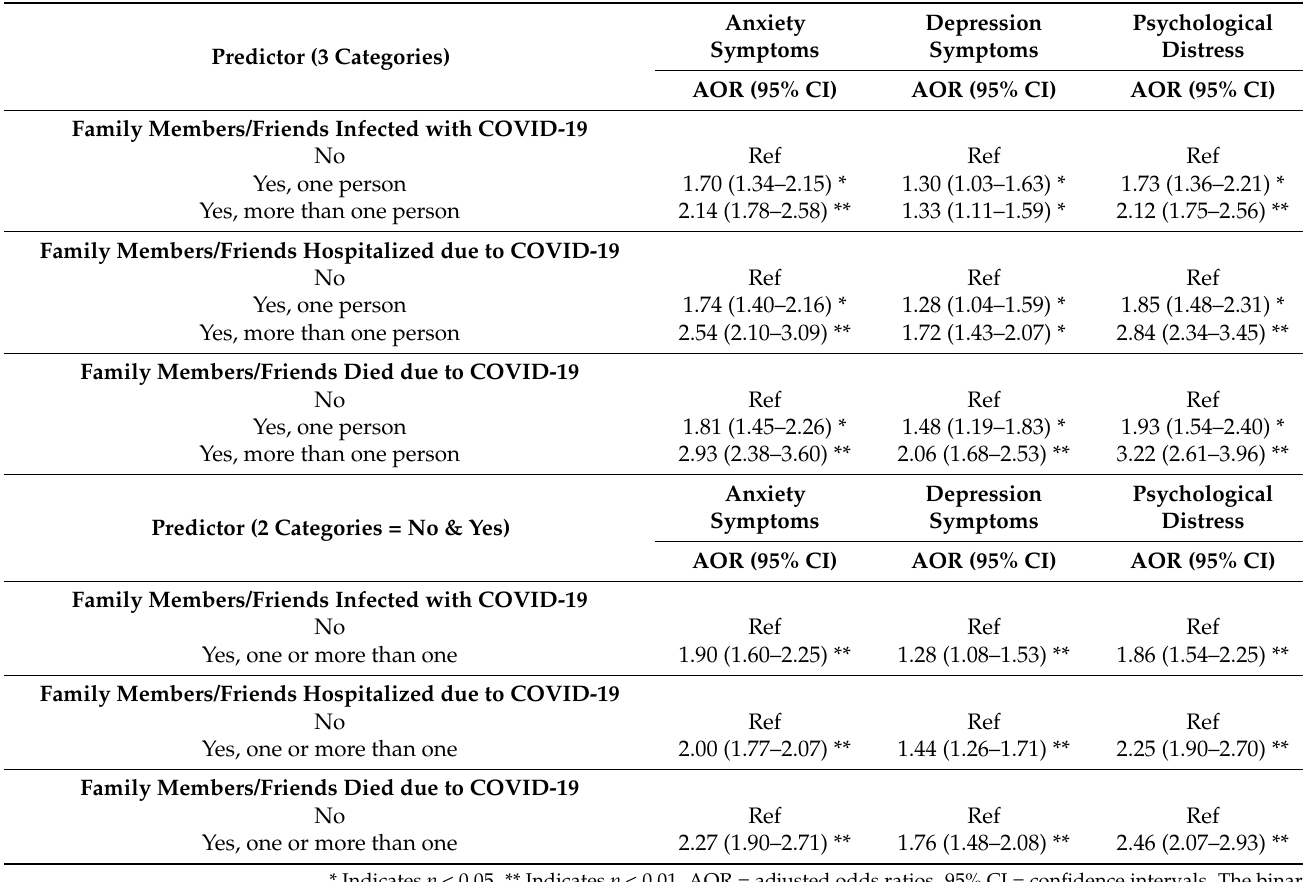
Table 3. Multiple Regression to Predict Depression/Anxiety Symptoms Based on COVID-19 Infection Among